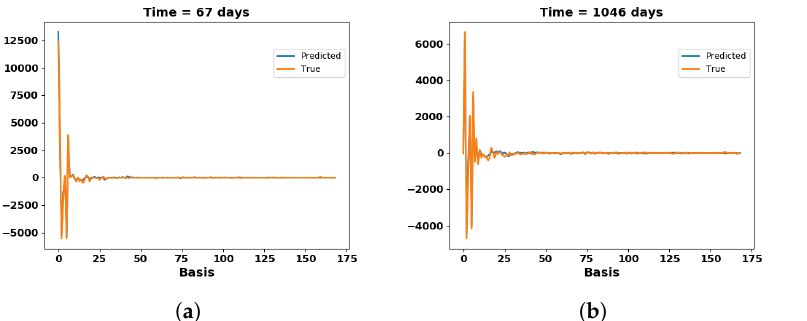
Figure 37. True and ML predicted pressure basis coefficient comparison at time = ( a ) 506 days and